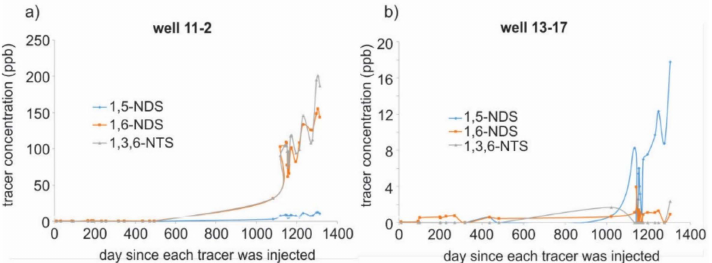
Figure 9. ( a ) Returns to well 11-2 of tracers 1,6-nds, 1,3,6-nts, and 1,5-nds that were injected into wells 13-13, 13-10A, and 13-5, respectively, on 2 May 2014; ( b ) returns to well 13-17 of the tracer 1,5-nds that was injected into well 13-5 during the 2014 tracing